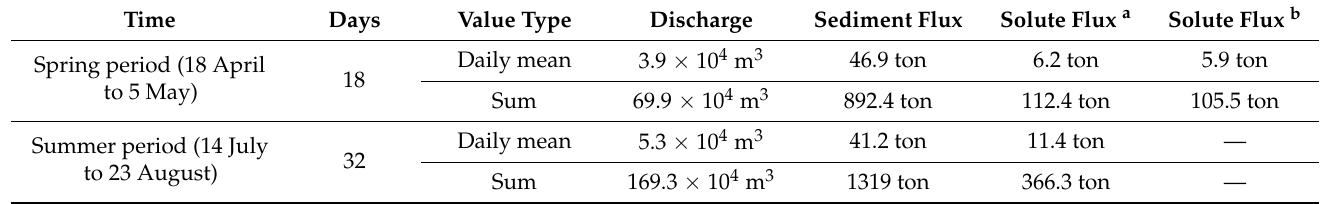
Table 2. Fluxes of discharge, suspended sediment, and solute in the Binggou stream water from 18 April to 5 May (the spring period) and from 14 July to 23 August (the summer